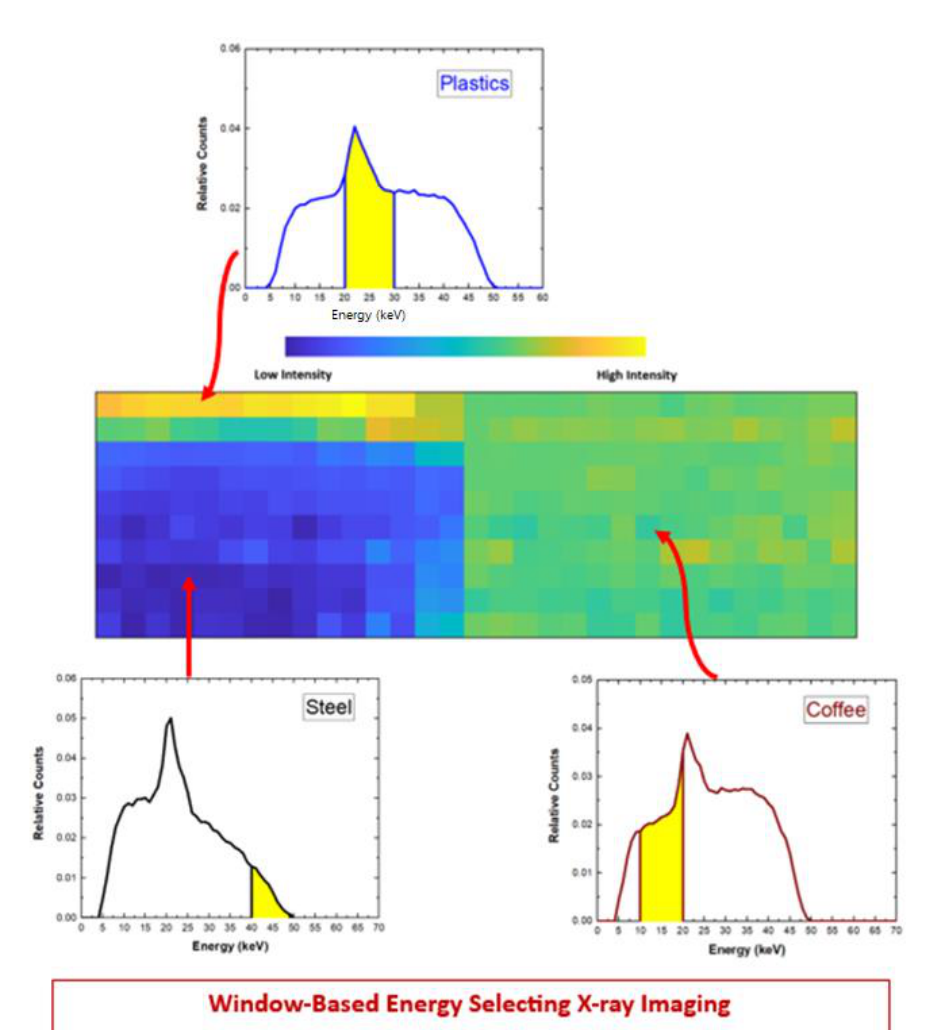
Figure 16. General overview of the window-based energy selecting X-ray imaging approach. The energy spectra of the pixels related to the three material zones (plastics, steel and coffee). The image is obtained by using the counts within the energy windows (yellow areas), selected to enhance the CNR . This technique, taking into account CNR enhancements between contaminants (steel and plastics)